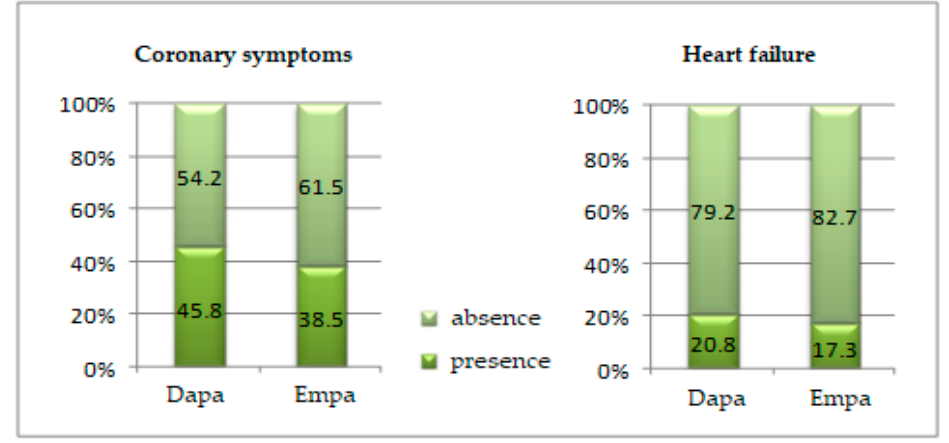
Figure 7. Comparison of the coronary syndrome and heart failure presence in the groups studied. Heart failure was diagnosed in 20.8% of the patients treated with Dapa and 17.3% of the patients treated with Empa ( p = 0.654) (Figure 7).